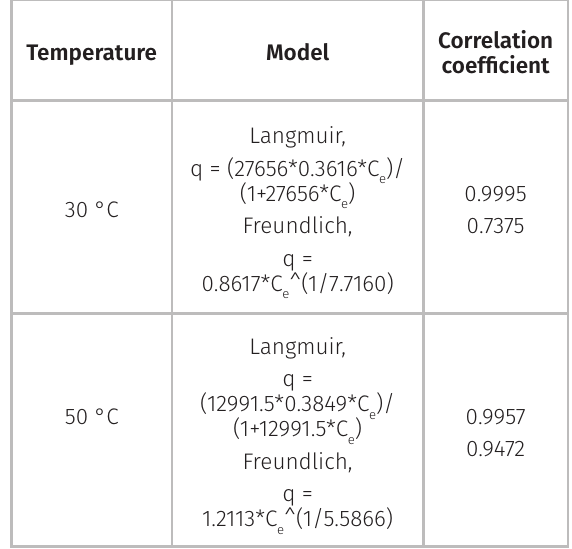
Table III. Isotherm models for the SCO surfactant adsorption on limestone.